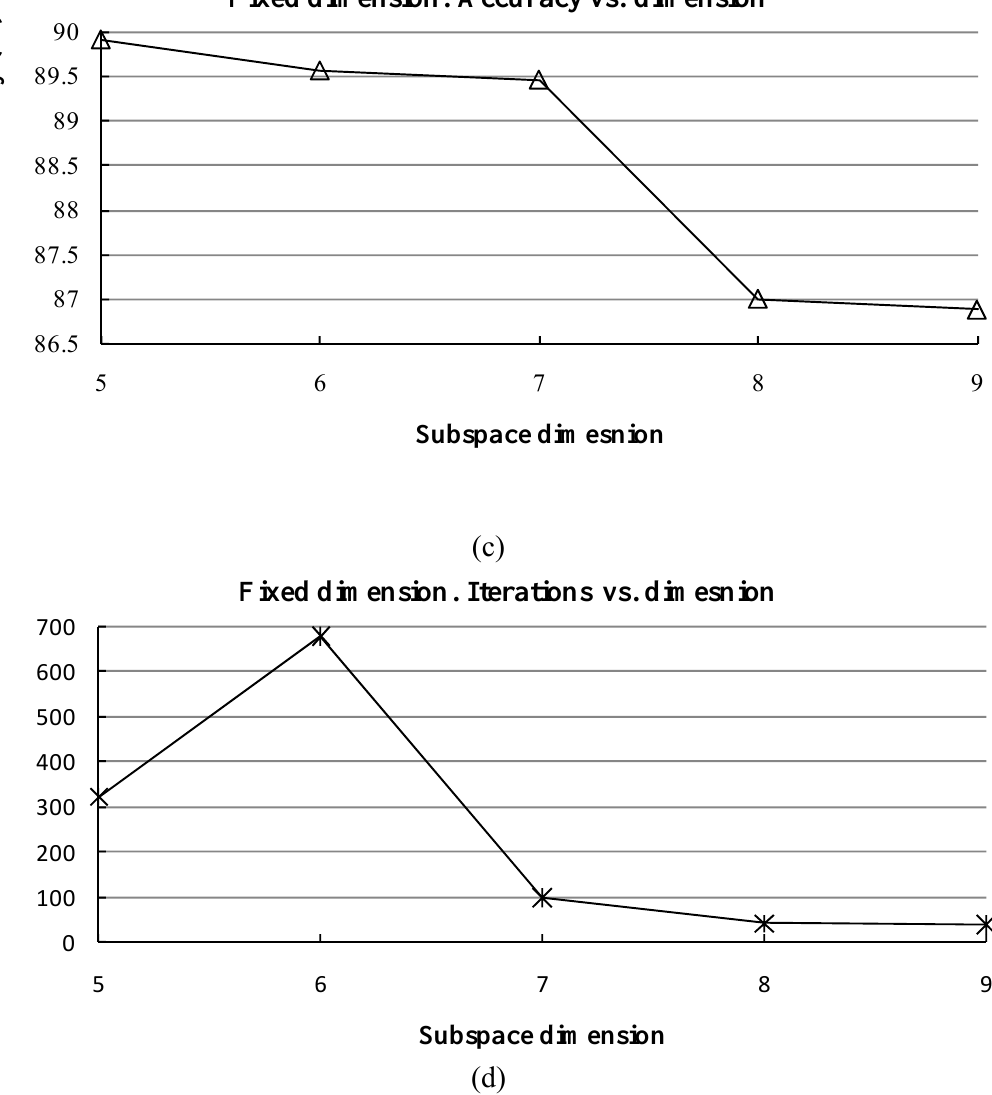
Subspace dimesnion